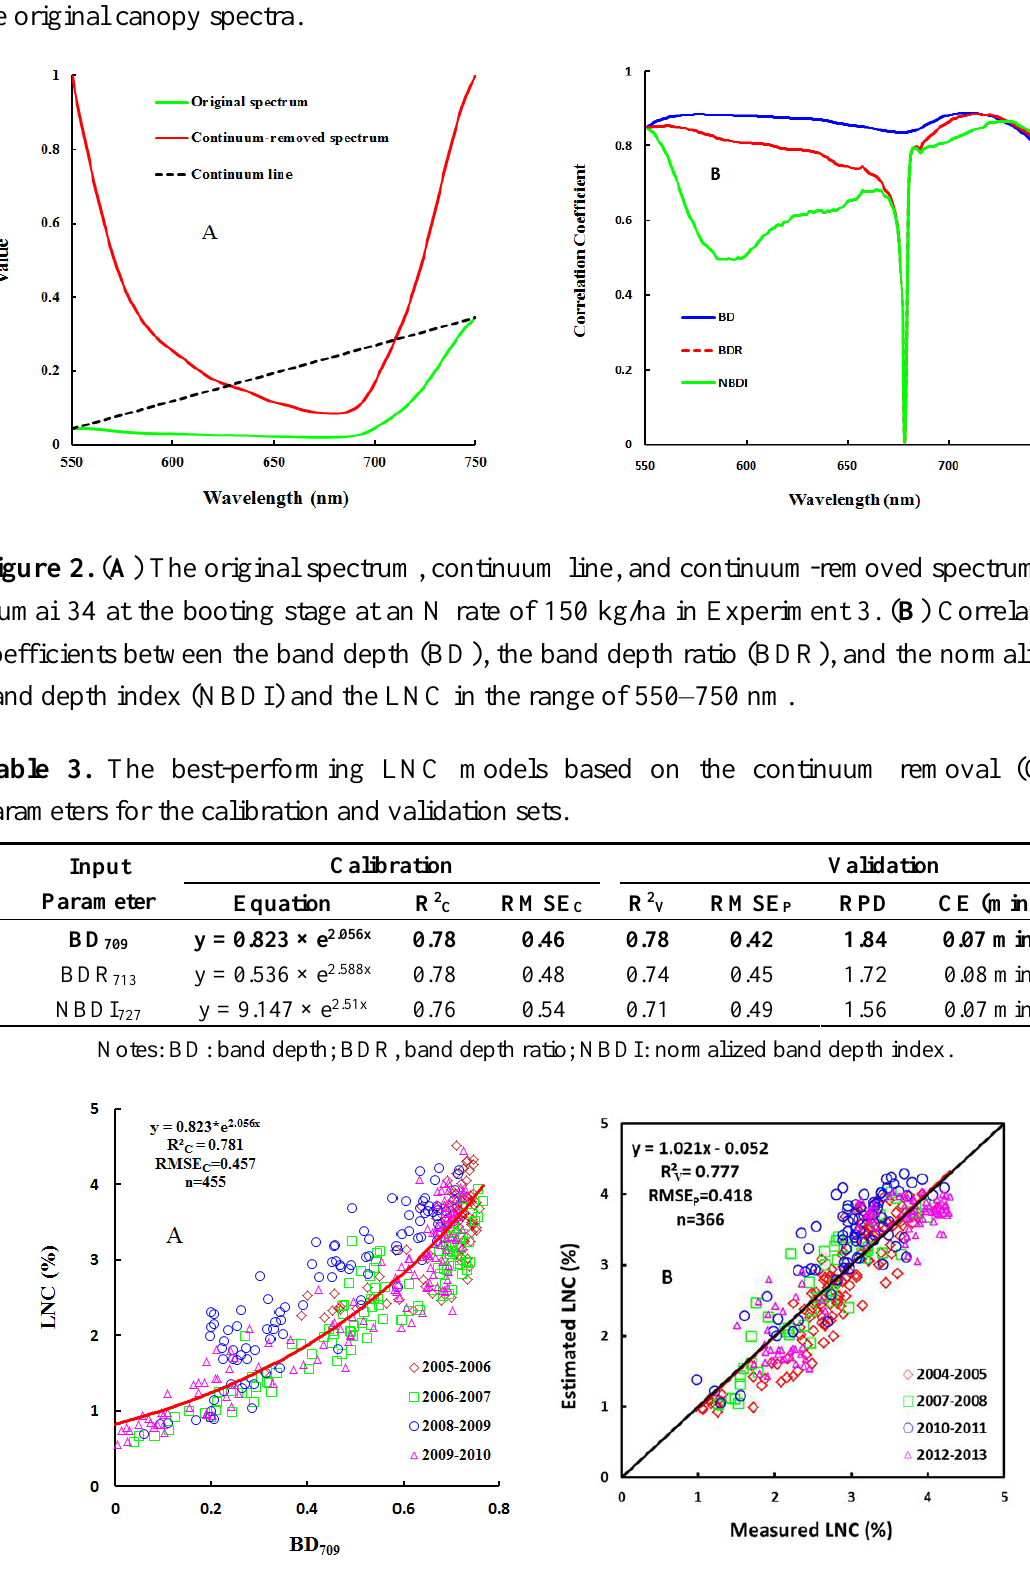
Figure 3. Calibration ( A ) and validation ( B ) of the model based on BD 709 from the original canopy